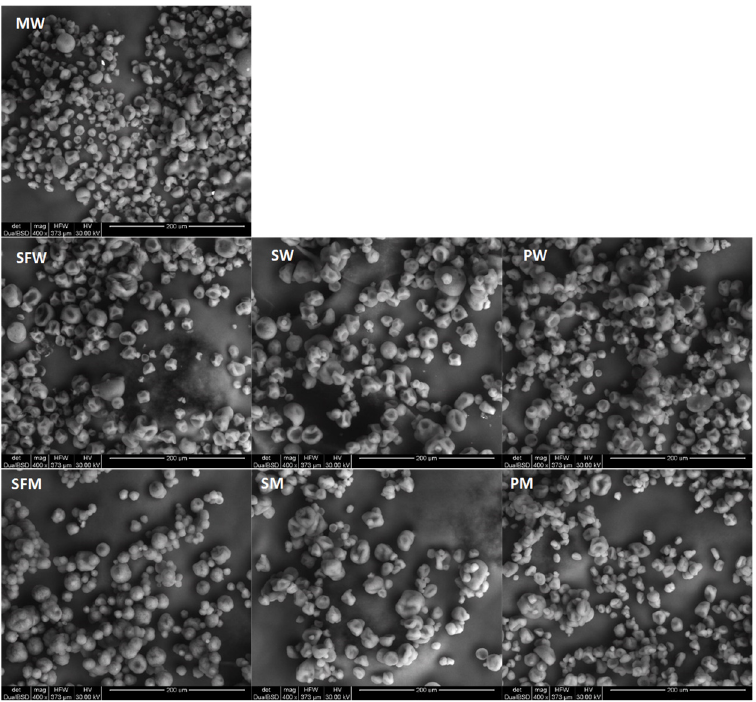
Figure 1. Scanning electron microscopy images for spray-dried emulsions formulated with M = maltodextrin, W = whey protein concentrate, SF = sunflower protein, S = soy protein, or P = pea protein as wall material.